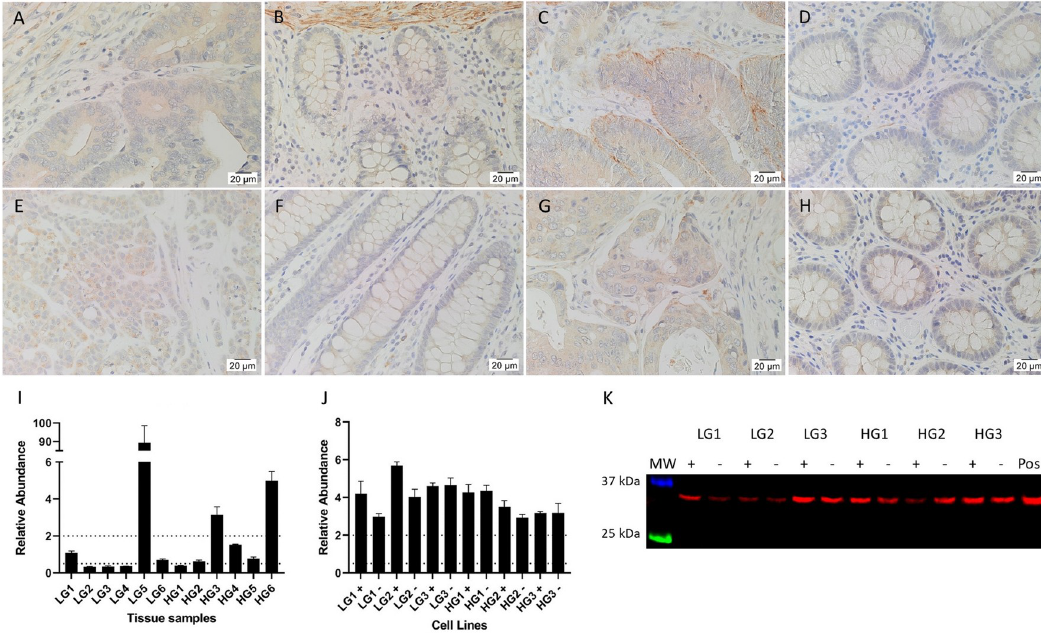
Fig 3. Expression of PRR. Representative IHC stained images of PRR (brown), including 2 LGCA samples (A, C) and their patient- matched NC tissues (B, D), and 2 HGCA samples (E, G) and their patient-matched NC tissues (F, H). Nuclei were counterstained with hematoxylin (A-H, blue); original magnification: 400x. PRR mRNA expression levels were measured by RT-qPCR in 6 LGCA and 6 HGCA tissues (I) and in 3 LGCA and 3 HGCA primary cell lines that were sorted into EpCAM High (+) and EpCAM Low (-) subpopulations (J). Abundance in CA tissues is displayed relative to patient-matched NC tissues, and relative to a pool of NC tissues for the CA-derived cell lines, with error bars representing standard deviation. PRR protein expression by cell lines was detected by WB (K; 35 kDa); positive control = tonsil. Adapted from [38] under a CC BY license, with permission from Munro MJ et al .